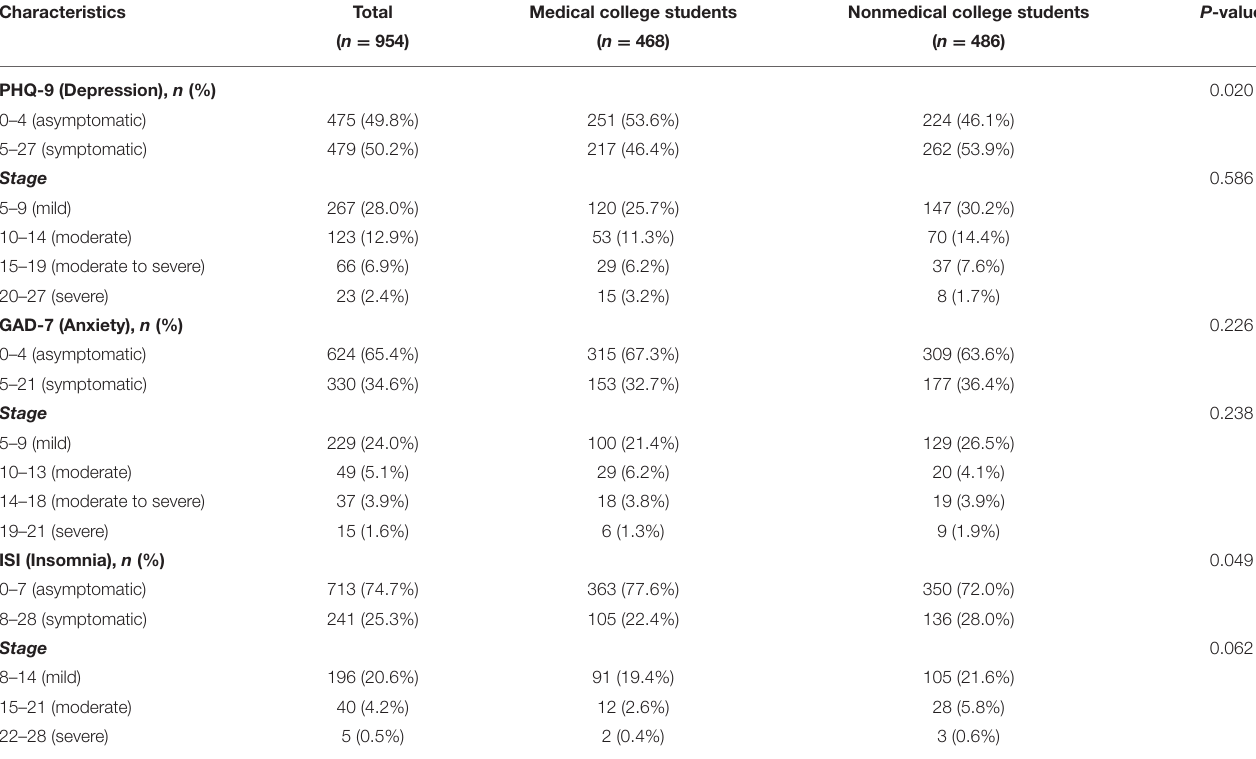
TABLE 2 | Mental health status in medical college students vs. nonmedical college students.